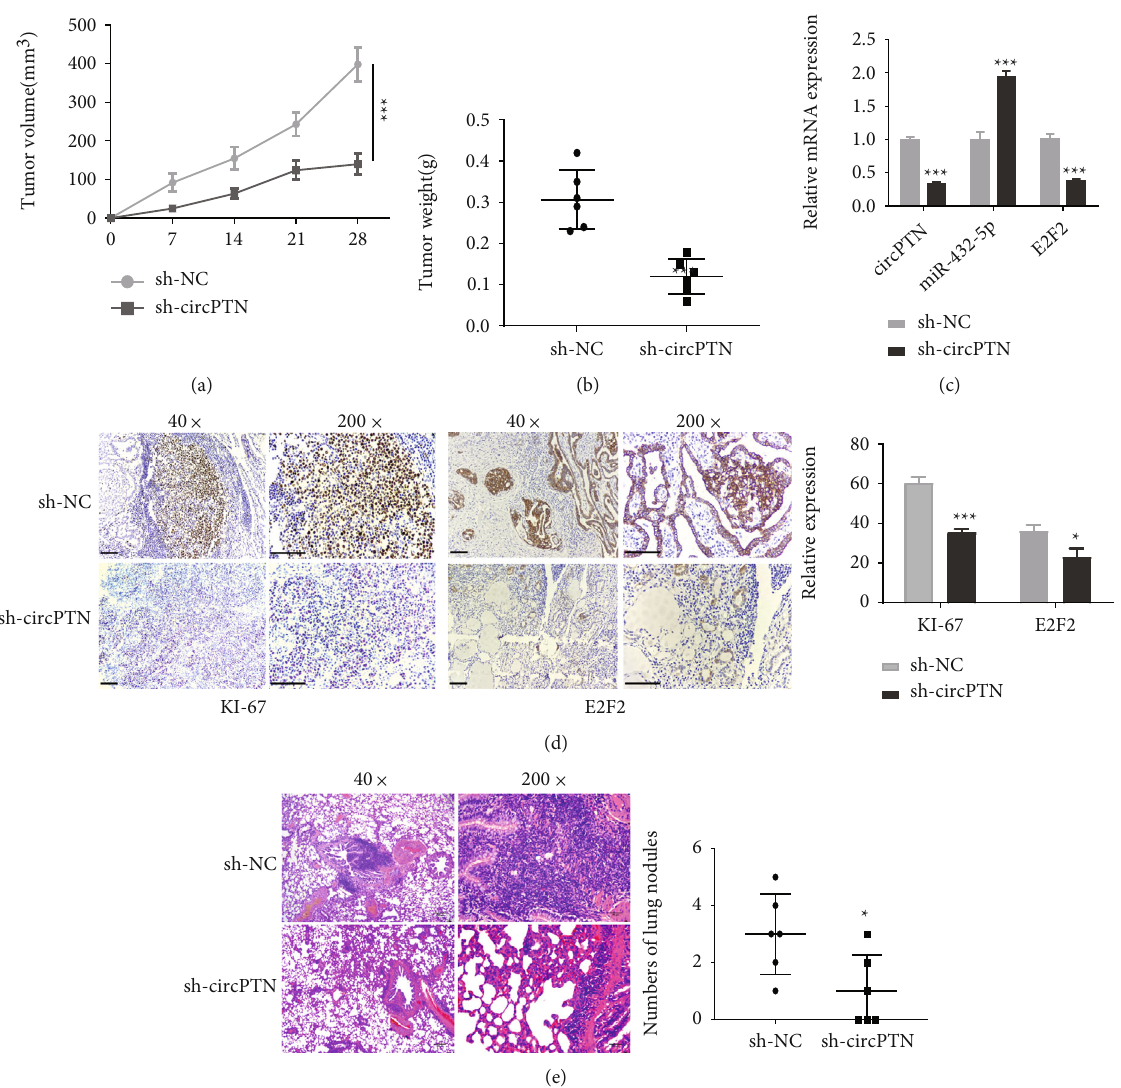
Figure 6: Knockdown of circPTN inhibits tumorigenesis and metastasis of NSCLC cells in vivo. (a) H1299 cells with sh-NC or sh-circTPN were inoculated subcutaneously in nude mice. Subcutaneous xenograft tumor size was measured every 7 days. (b) Subcutaneous tumor mass of H1299 cells in di ff erent groups was measured on day 28. (c) The expression levels of circPTN, miR-432-5p, and E2F2 in subcutaneous tumors of di ff erent groups were quanti fi ed by qRT-PCR. (d) The protein levels of Ki-67 and E2F2 in subcutaneous tumor tissues in di ff erent groups were detected by immunohistochemistry (IHC). (e) H&E staining was performed to examine pulmonary metastatic nodules in the lung tissues of the two groups. * P < 0 : 05 ; ** P < 0 : 01 ; and *** P < 0 : 001